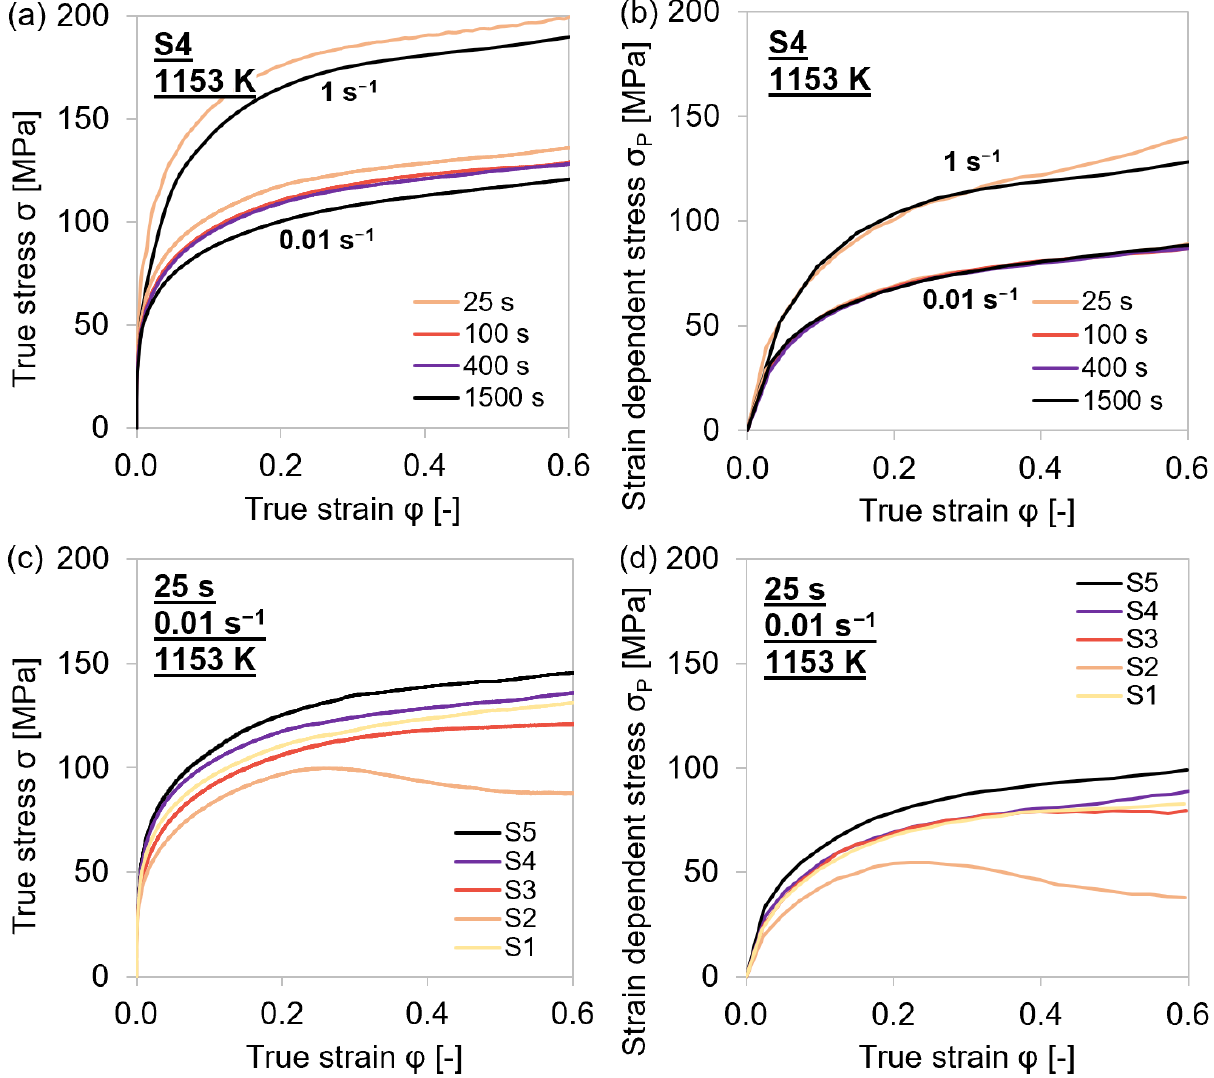
Figure 8. Comparison of experimental stress–strain and flow curves during single-hit compression tests with 25–1500 s holding times before deformation and 0.01–1 s − 1 strain rates at 1153 K of MA steel grades S1–S5. ( a , c ) Entire stress–strain curves. ( b , d ) Flow curves for strain hardening area III. It became obvious that while the difference in the stress–strain curves for different holding times mainly stemmed from a difference in σ 0 —i.e., the curves in Figure 8b almost perfectly overlap—a change in the material had a much more pronounced influence on the values of θ 0 and σ ∞